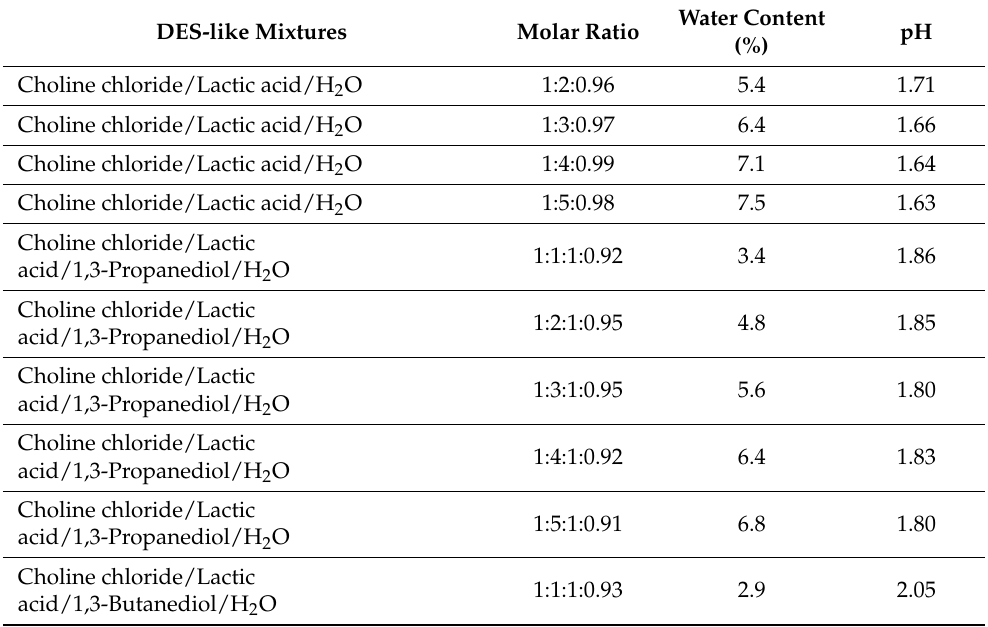
Table 13. Prepared DES-like mixtures, molar ratios and their pH values at 298.15 K, and the concen- tration of DES-like mixtures at 1 mol/L (adapted according to Jablonsk ý et al.) [50]. Water Content DES-like Mixtures Molar Ratio (%)